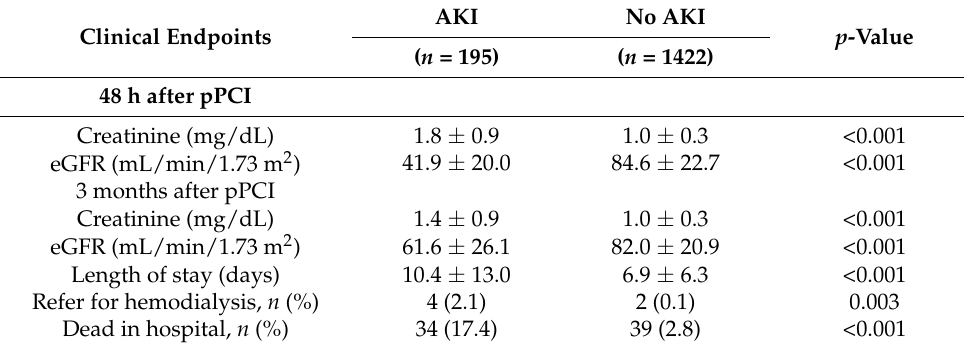
Table 4. Endpoints and prognosis of patient with or without AKI after